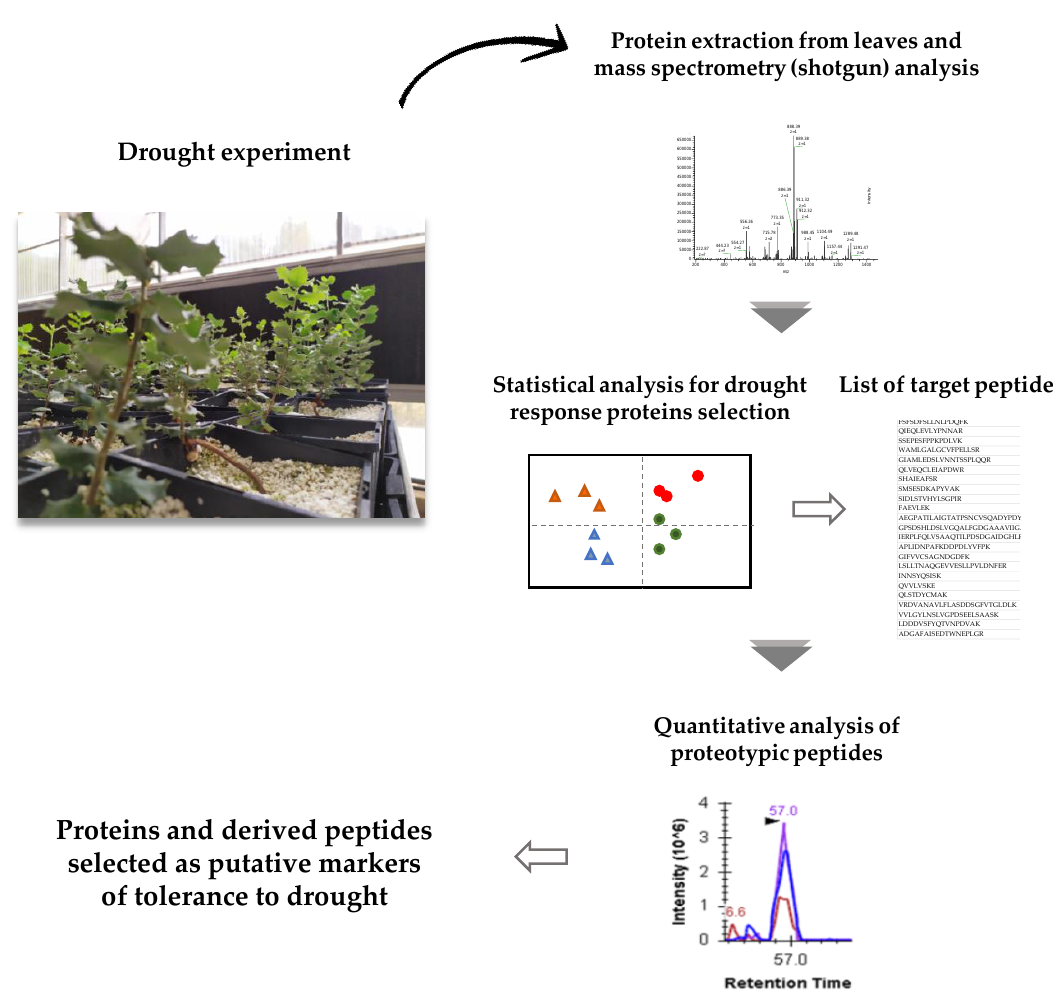
Figure 1. Schematic workflow for selection of putative markers of drought tolerance. Multivariate analysis integrating the entire dataset is shown in Supplementary Figure S2A, where the first two components (25% of the total variability) separated populations. Hierarchical clustering was also performed and represented in a dendrogram (Supple- mentary Figure S2B), in which two main clusters were observed: one grouped Huelva and Granada populations, and the other grouped Seville and Cadiz, independently of the sampling time. Replicates of the same experimental condition (population, treatment and sampling time) were grouped, demonstrating reproducibility throughout the experi- ment. To check the effect of stress on the populations, the sampling times were analyzed separately by partial least-squares regression analysis (PLS-DA) (Figure 2). The first two components explained 20% (first sampling time) and 31% (second sampling time) of the total variability. Component 1 resolved Cadiz control plants, and component 2 resolved plants under drought for 17 days (first sampling) from control plants except in the